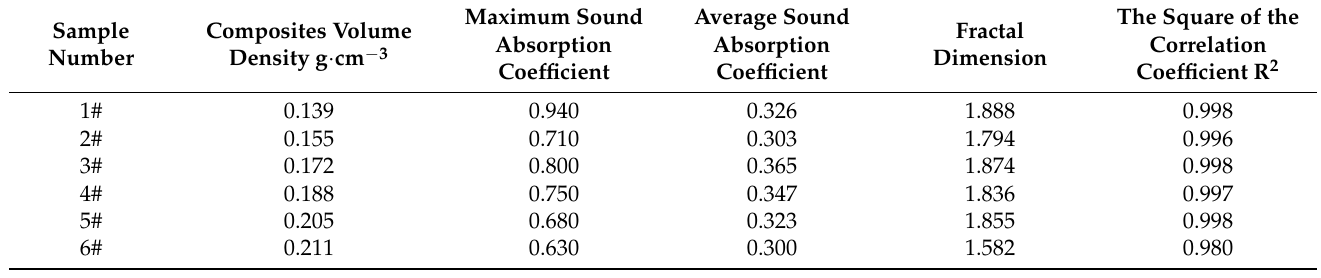
Table 1. Relevant parameters of samples at different volumetric densities.